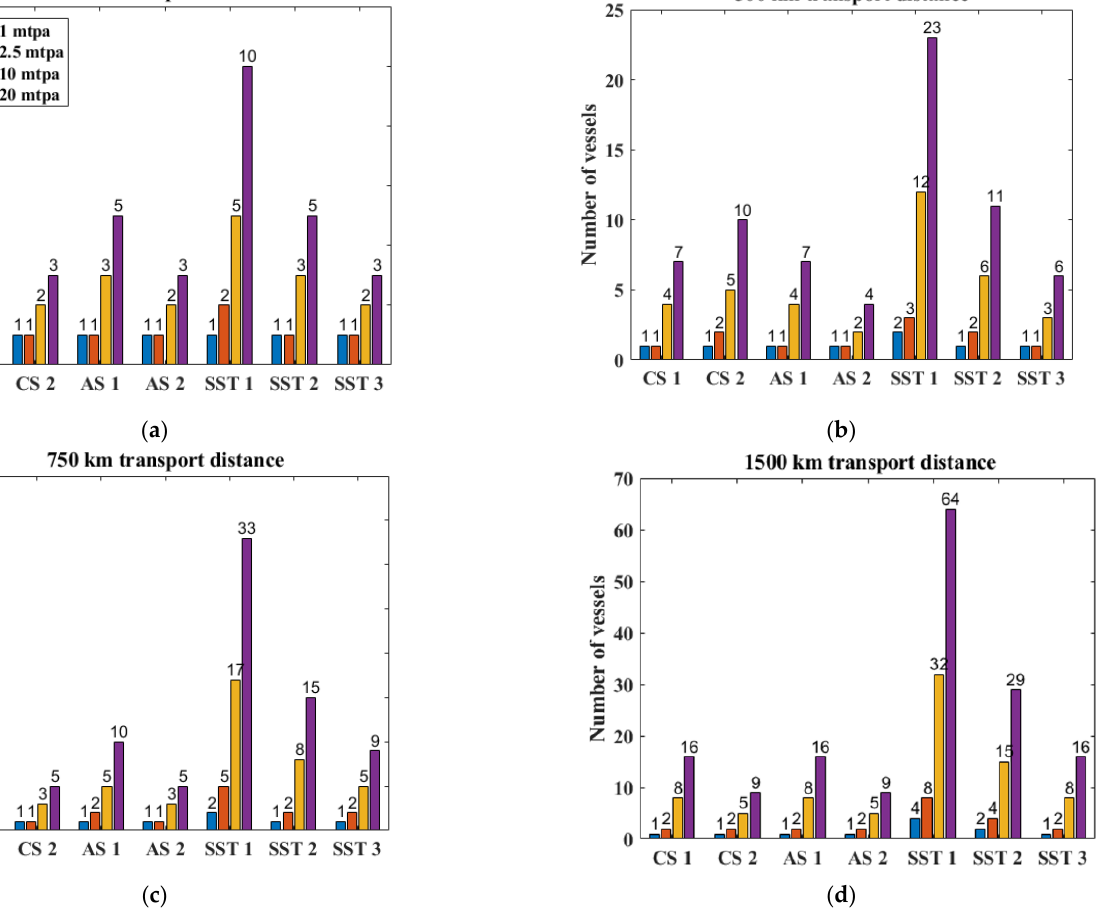
Figure 8. Number of vessels required on different source volumes and transport distances: ( a ) 180 km; ( b ) 500 km; ( c ) 750 km; ( d ) 1500 km. ( b ) 500 km; ( c ) 750 km; ( d ) 1500 km.